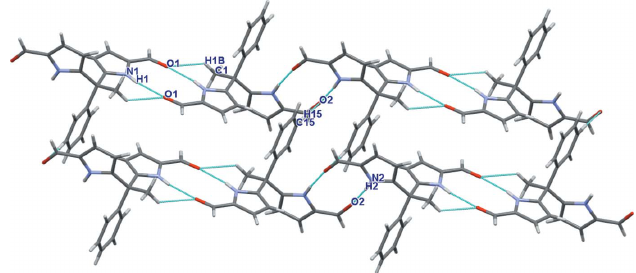
Figure 2 Illustration of the different hydrogen bonds (N—H (cid:3)(cid:3)(cid:3) O and C—H (cid:3)(cid:3)(cid:3) O) in the title compound viewed along [001]. Hydrogen bonds are drawn as dashed